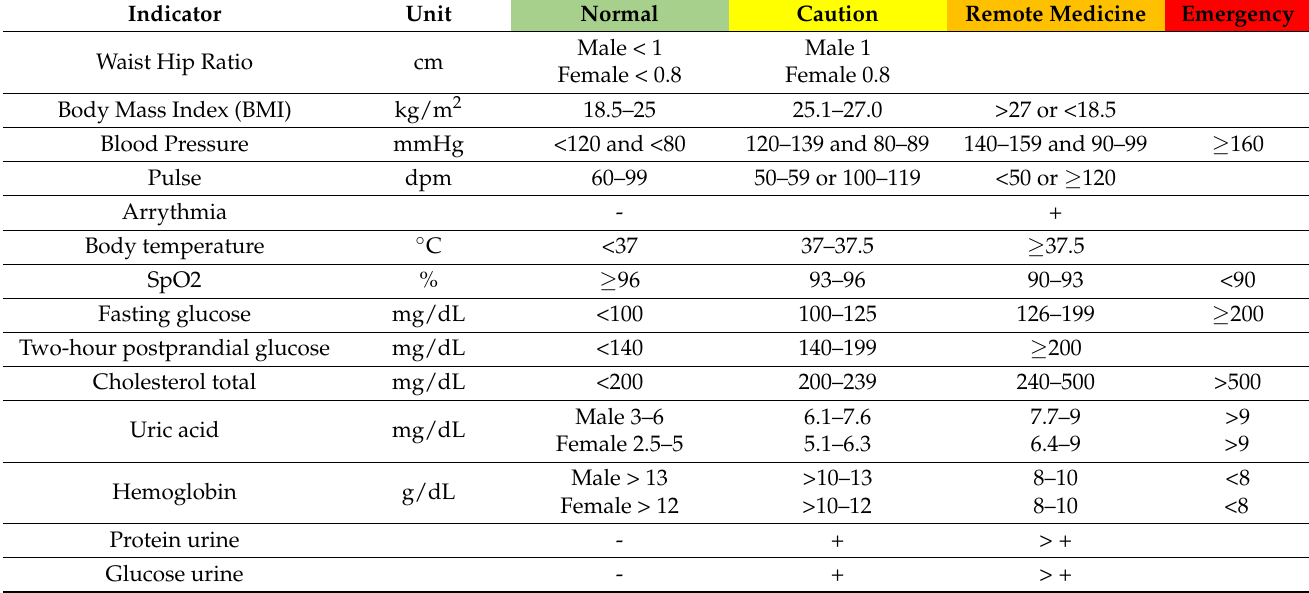
Table 1. Algorithm items to calculate the patient’s health risk [24].